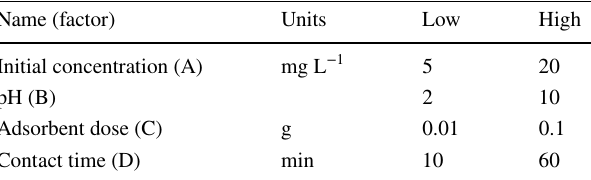
Table 2 Variables and levels considered for the adsorption of carba-